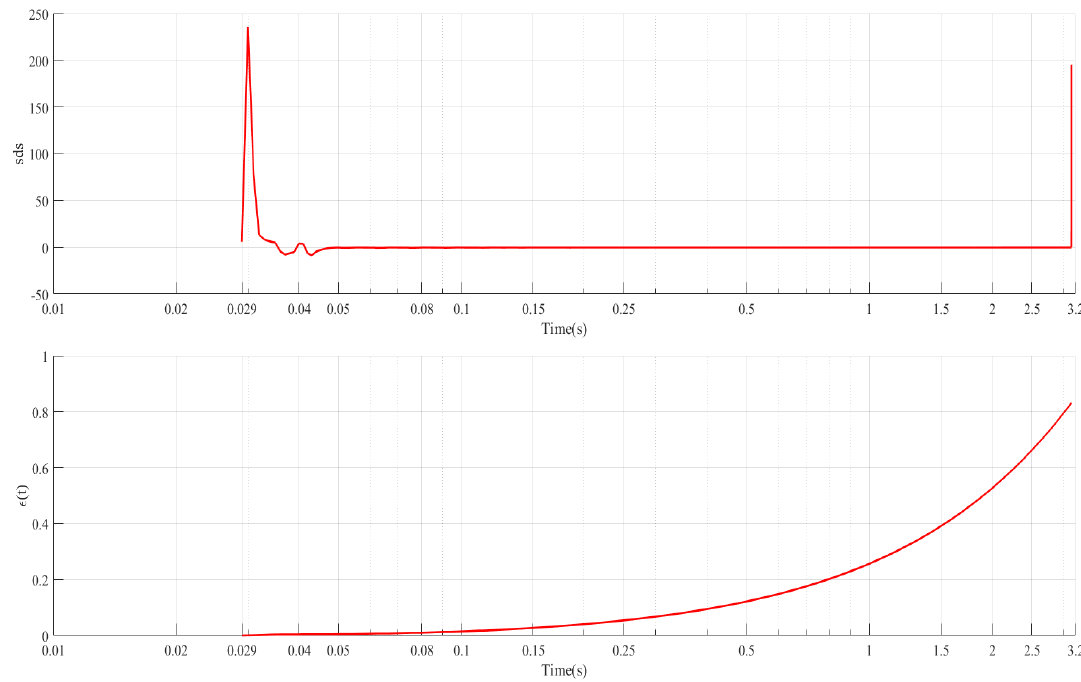
Figure 16. The output parameters of fuzzy sliding control